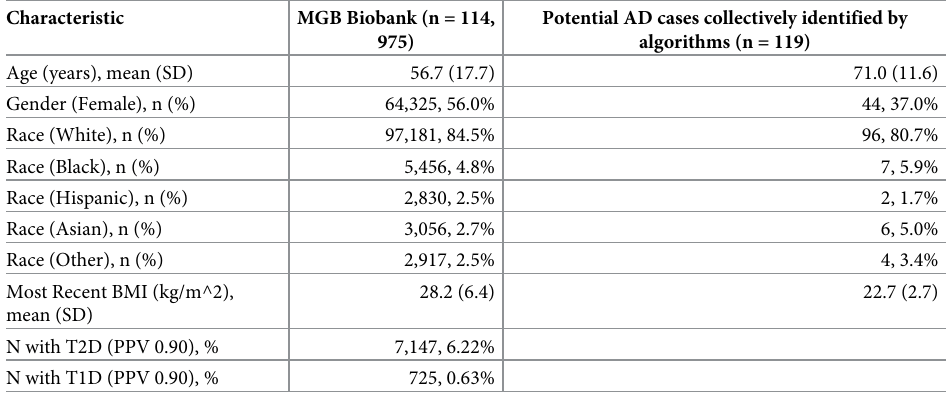
Table 1. Baseline characteristics by biobank vs. algorithm-identified.